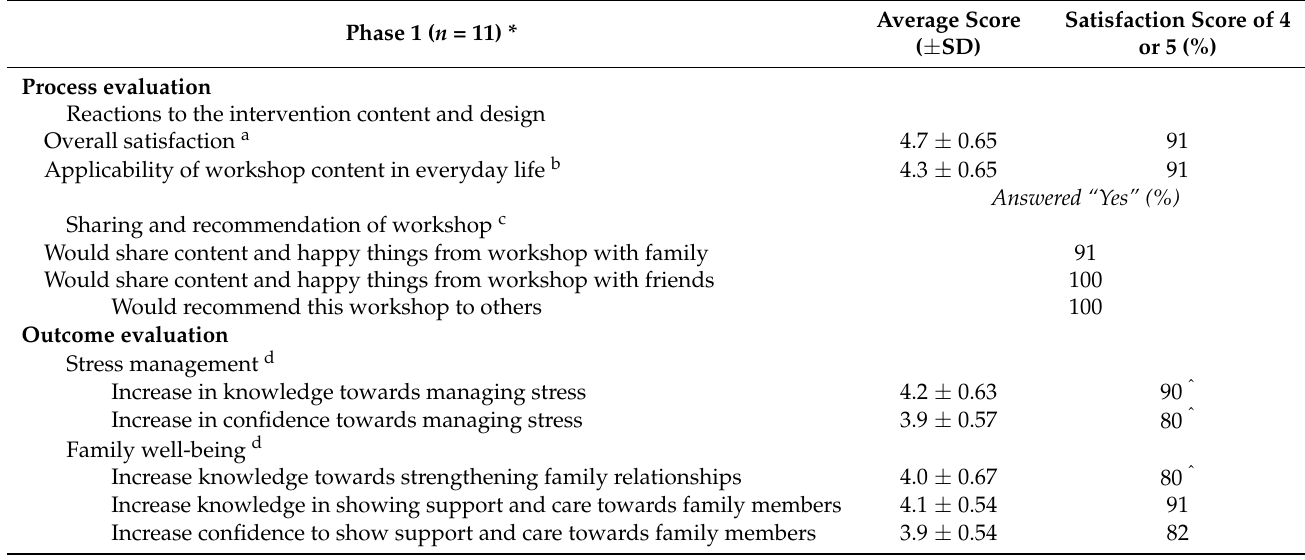
Table 2. Evaluation of Caritas Aberdeen IFSC’s face-to-face Zentangle workshop (Phase 1, n =